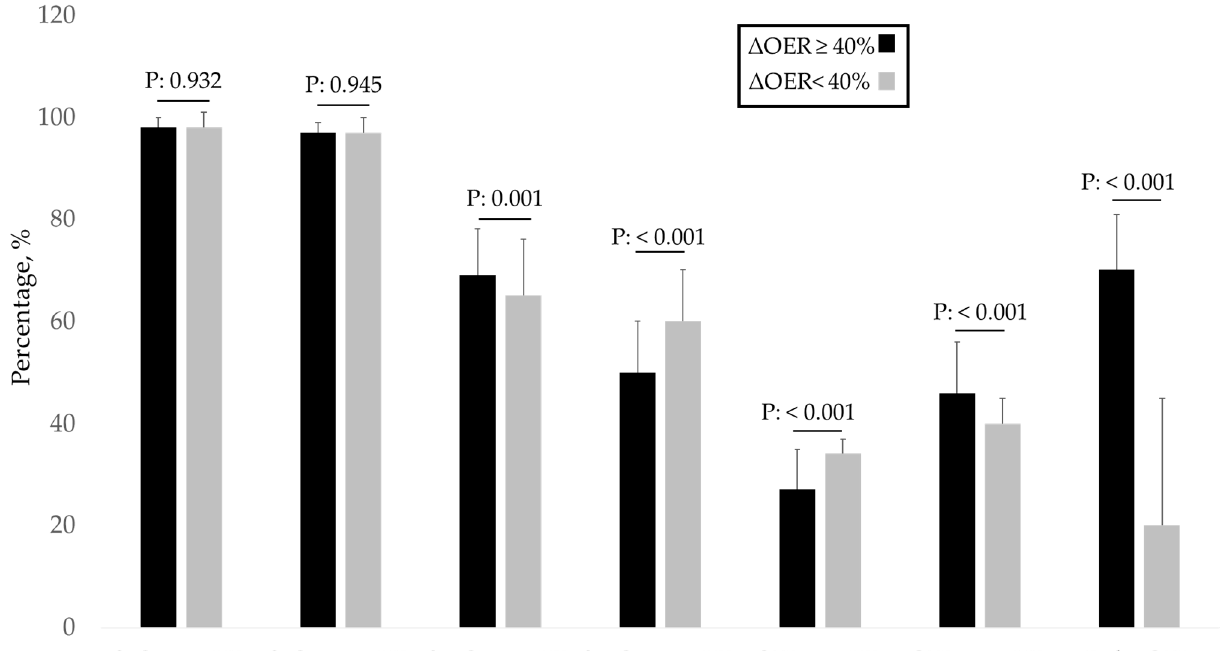
Figure 2. Oxygen parameter in the two groups Δ OER ≥ 40% and Δ OER < 40%. ScvO2, central venous SO2; SaO2, arterial SO2; OER, oxygen extraction ratio; ∆ OER, variation in OER.